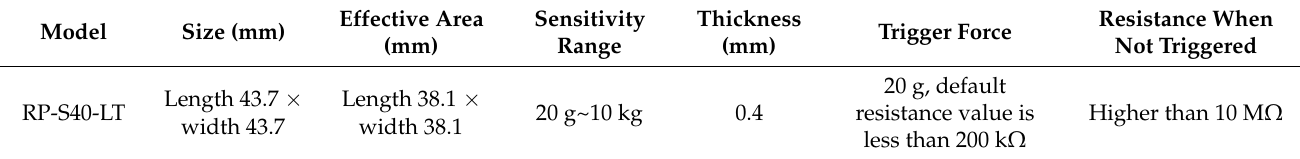
Table 3. Thin-film pressure sensor parameters.